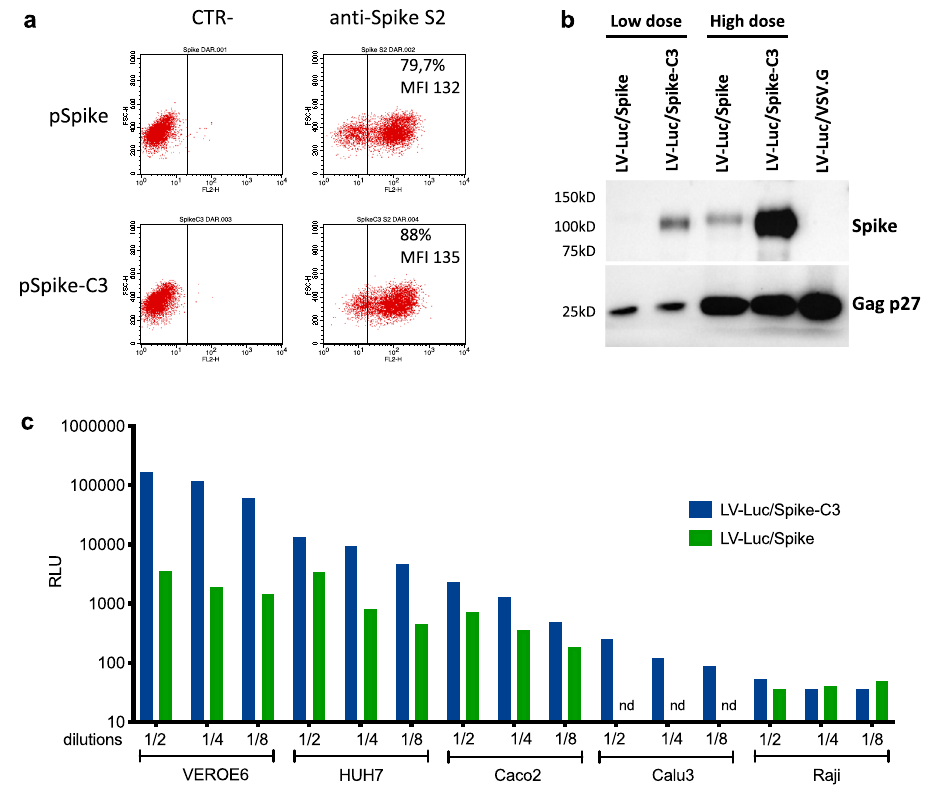
Fig. 1 Higher incorporation of truncated Spike on LV pseudovirions improves infectivity in ACE2 + cell lines. a Evaluation of SARS-CoV-2 spike expression in 293T Lenti-X cells transfected with pSpike and pSpike-C3 plasmid by fl ow cytometry. Data from one representative experiment of three independent experiments are shown. b Western blot (WB) of lysates from concentrated preparations of LV-Luc pseudotyped with wild-type spike (LV-Luc/Spike) or spike truncated (21aa) at the cytoplasmic tail (LV-Luc/Spike-C3). Low dose: 1 × 10 5 reverse transcriptase (RT) units; High dose: 6 × 10 5 RT Units. Control vector included LV-Luc pseudotyped with VSV.G envelope (LV-Luc/VSV.G). Data from one representative of three independent experiments are shown. c Infection of human and macaque epithelial cell lines and the control B cell line Raji incubated with decreasing concentrations of LV-Luc pseudotyping the full length (LV-Luc/Spike) or the truncated form (LV-Luc/Spike-C3) of the SARS-CoV-2 spike. Data are expressed as mean luciferase activity (RLU) of duplicates. Nd = not done. Source data are provided as a Source Data fi